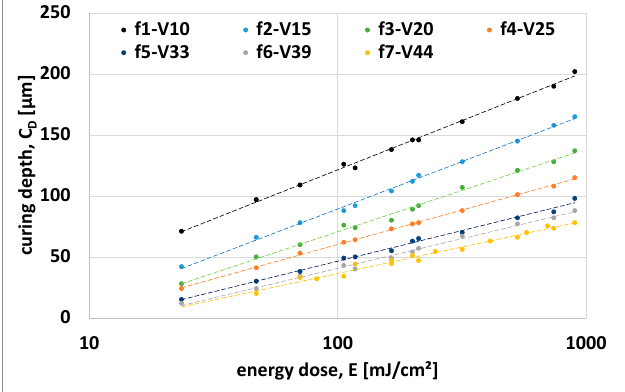
Figure 5. Curing depth via energy dose for various solid loadings. As expected, the cure depth decreases significantly with increasing solid loading. For instance, up to a 1000 mJ/cm 2 energy dose for a 10 vol% AlN loading, the cure depth ranged between 75 and 200 µm, and in contrast for a 44 vol% AlN content, the cure depth decreased to a range of 30 to 80 µm. The penetration depth ( D P ) and the critical energy ( E C ) can be determined based on the measured values. By plotting them against the solids loading ( ϕ ) (Figure 6), the dependence can be shown.